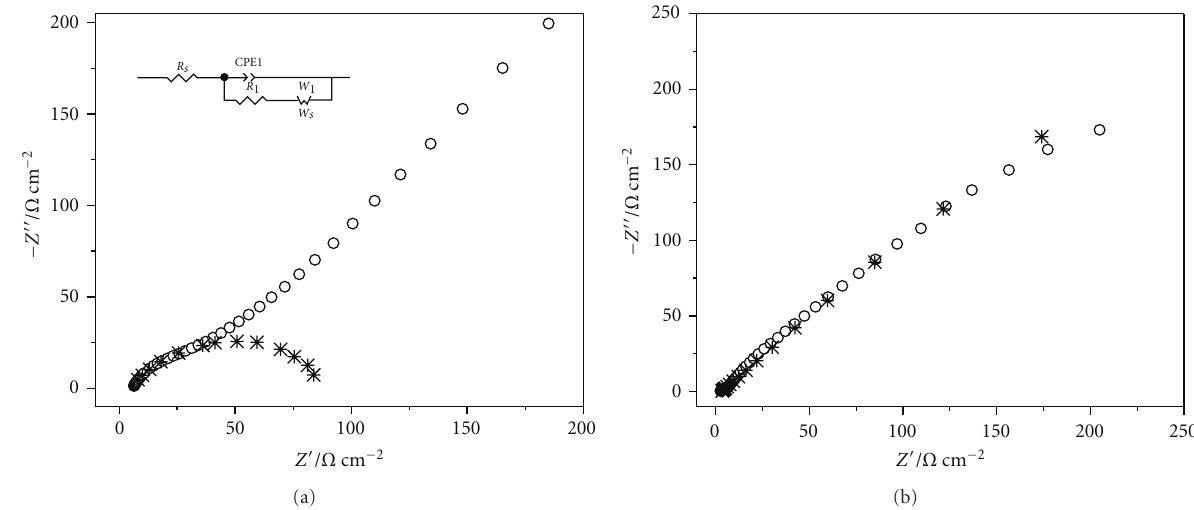
Figure 2: Typical Nyquist plots: (a) carbon nanotube paste electrode (60% w/w), (b) CNTs-AChE biosensor in 5.0mM K 3 [Fe(CN) 0.5M KCl solution. Insert: the proposed Randle’s